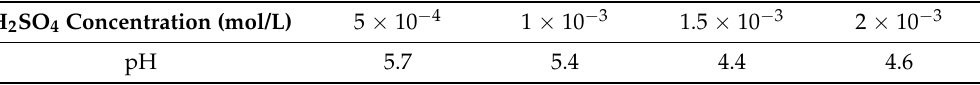
Figure 2. Contact angles of dolomite and fluorapatite conditioned with sulfuric acid and 1 means 1 × 10 −4 mol/L and2 means 2 × 10 −4 mol/L of oleate. Table 2. The pH values of dolomite slurry with the addition of H 2 SO 4.